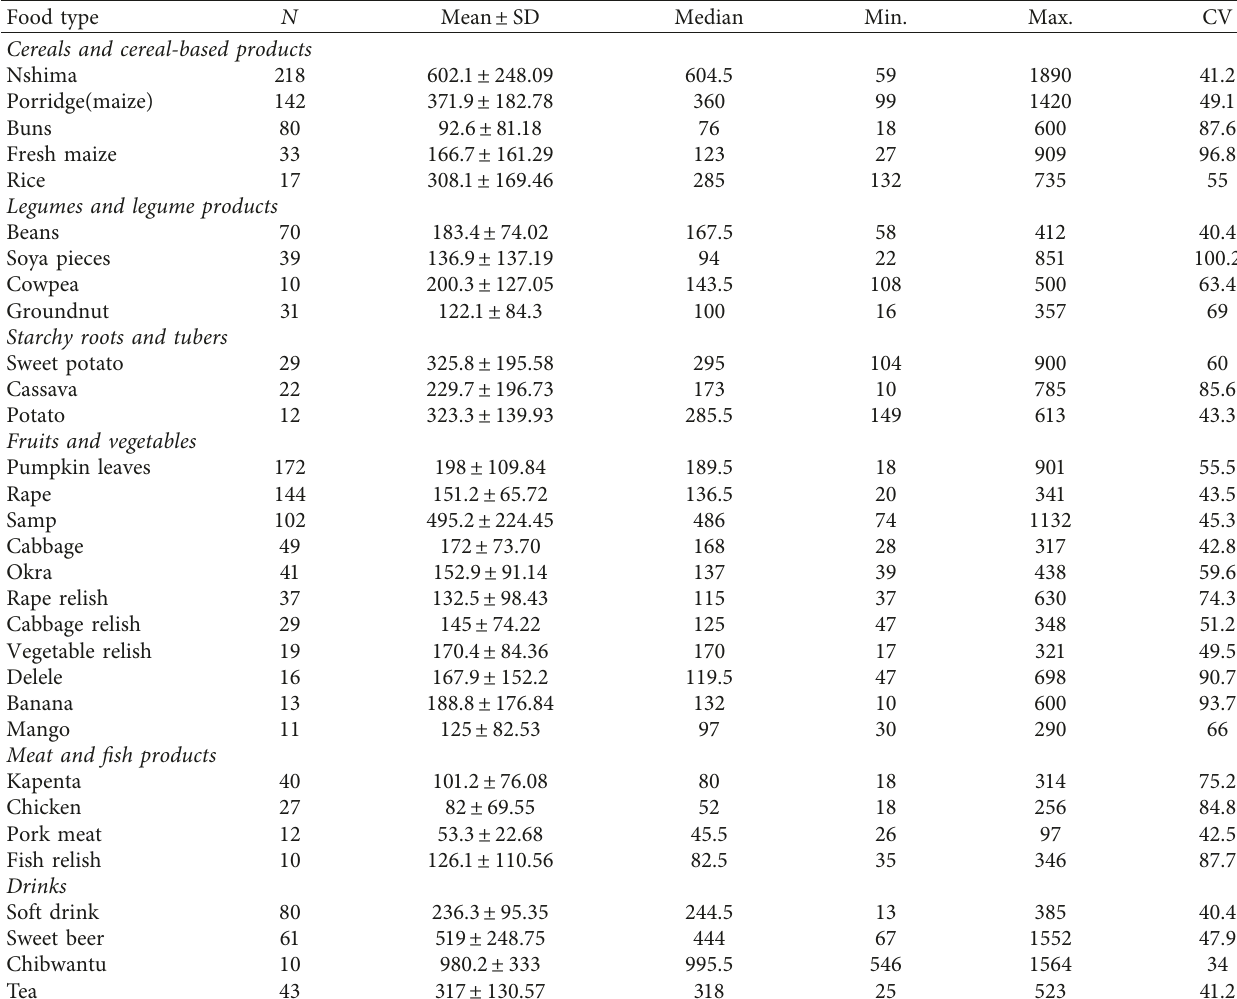
Table 5: Food frequency and weight (grams) consumed by mothers in